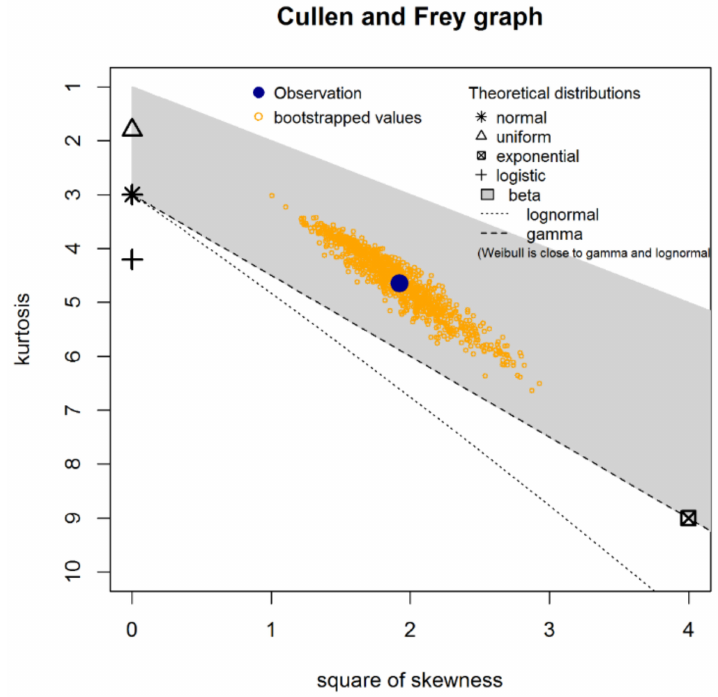
Figure 6. The Cullen and Frey graph of areal average monthly precipitation for the observations.